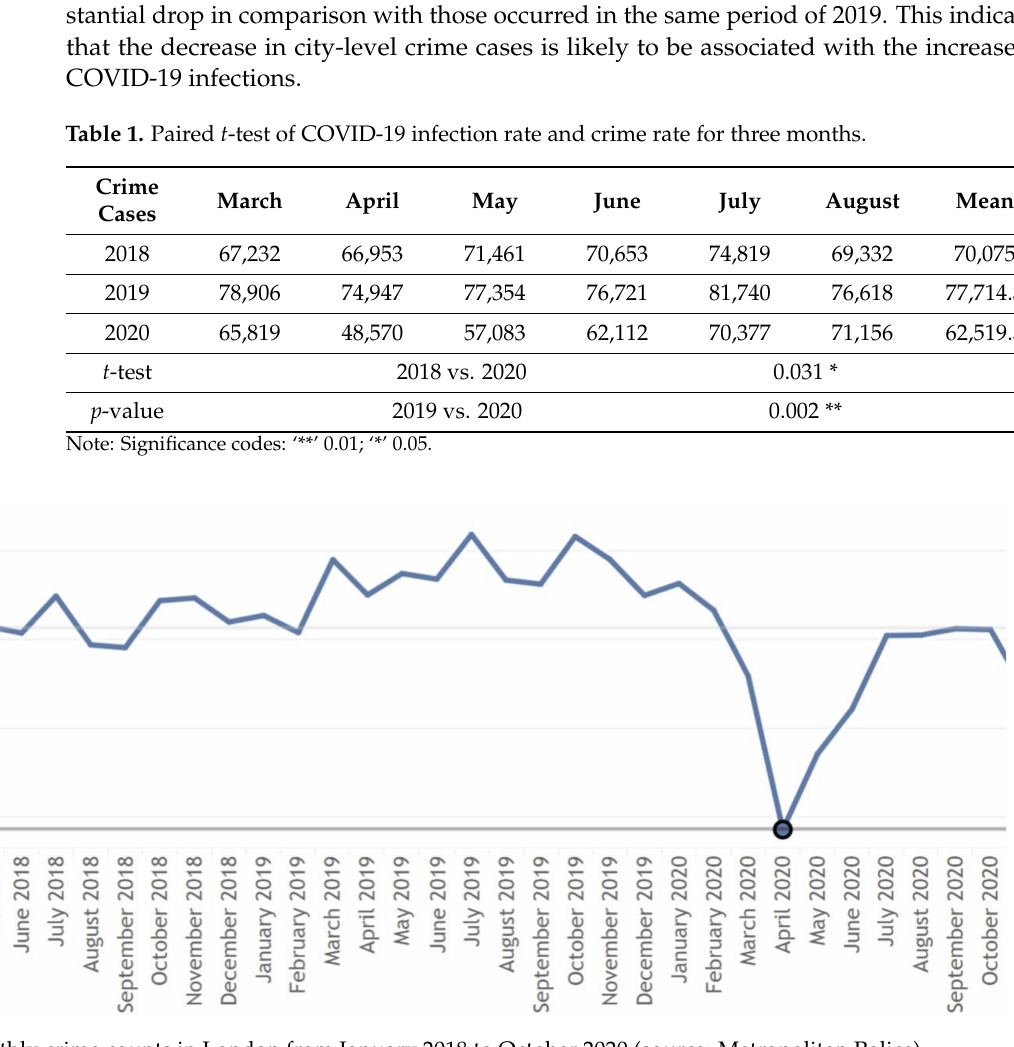
Figure 1. Monthly crime counts in London from January 2018 to October 2020 (source: Metropolitan